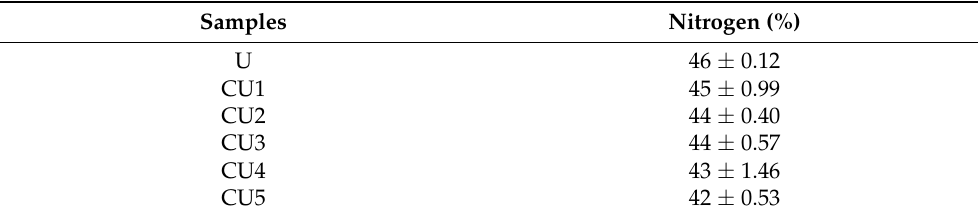
Table 4. Nitrogen content of uncoated urea and rejected sago starch-coated